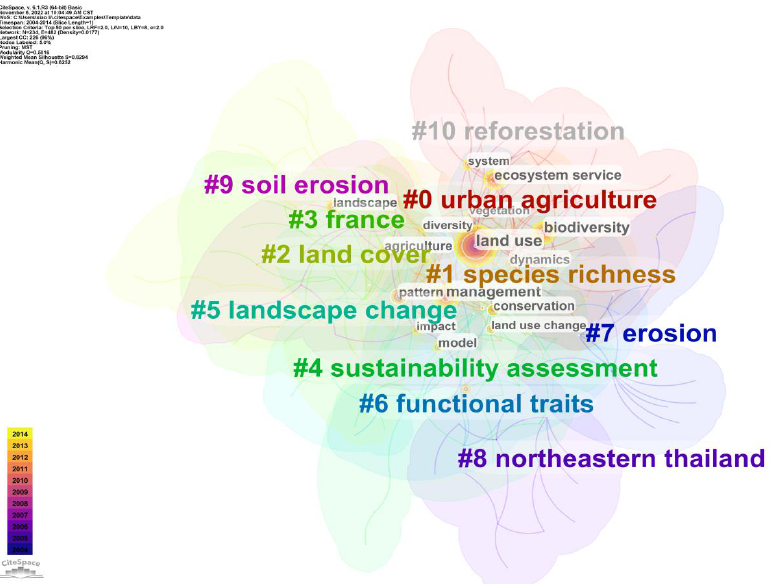
Figure 6. Cluster map of keywords of agricultural land function in the development stage (the leg- end represents the color display for each year from 2004 to 2014).